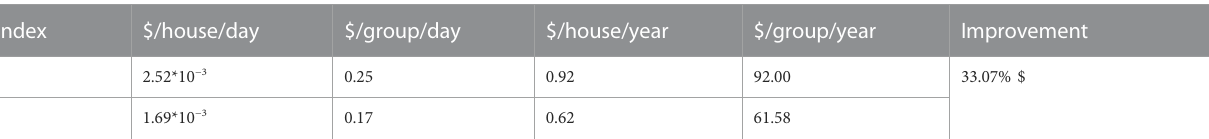
TABLE 3 Carbon emission cost of a single house and house